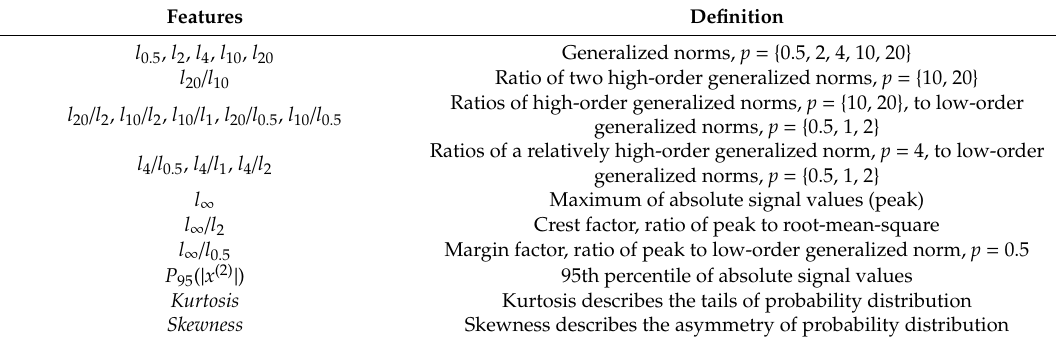
Table 2. Definitions for twenty features.